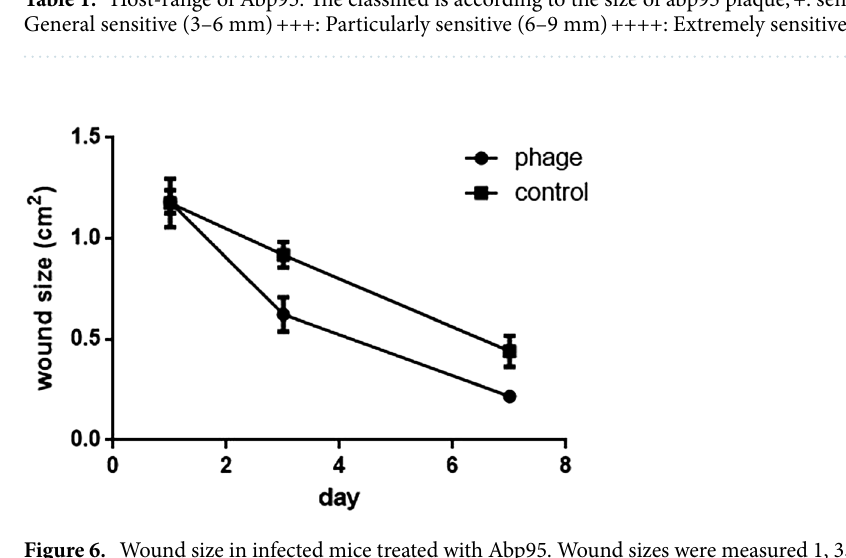
Figure 6. Wound size in infected mice treated with Abp95. Wound sizes were measured 1, 3, and 7 days after infection and are shown as mean ± standard deviation. There was no statistical difference between the control group and the phage treatment